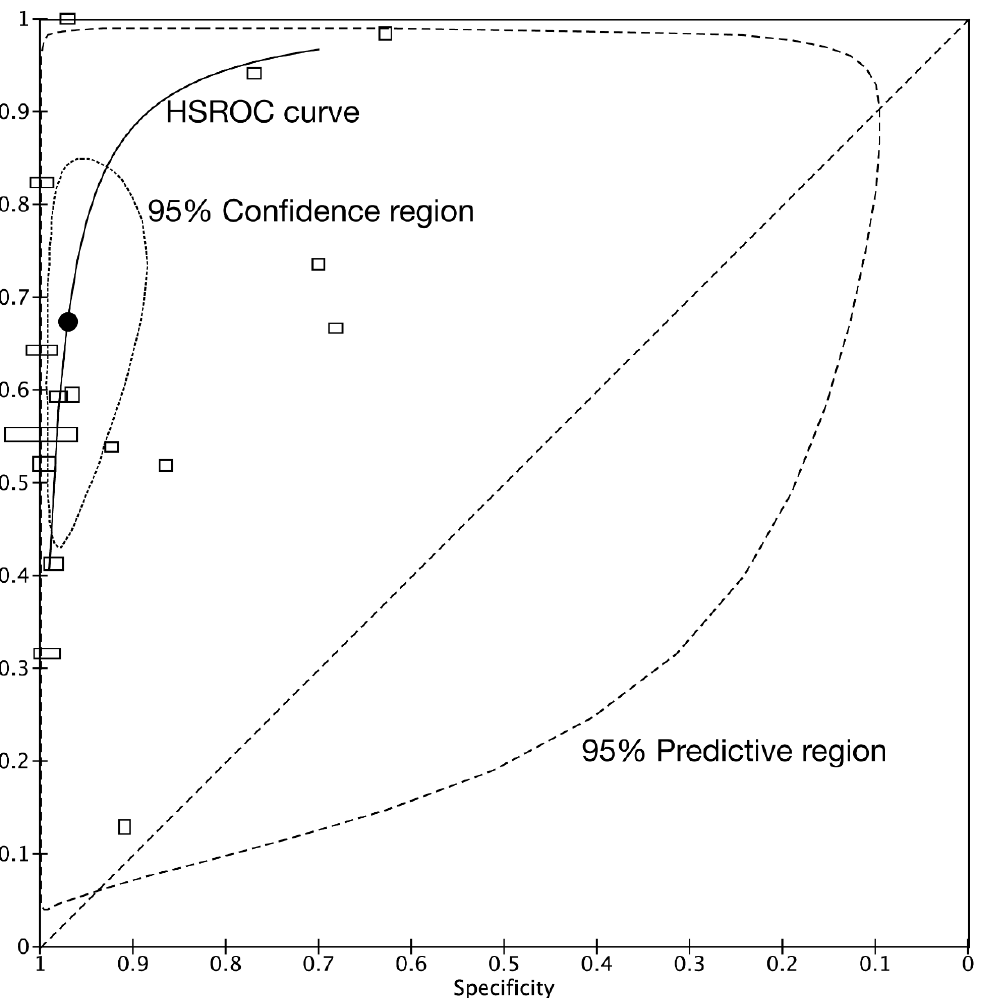
Figure 5. Summary receiver operating characteristic curves from all included studies. The dotted line represents the theoretical plot of a test with no discrimination ability. The summary ROC curve can be drawn through these values. The summary point estimate (black point) and its 95% confidence region are shown. The height of the rectangles is proportional to the number of patients with traumatic hollow viscus injuries across studies, and the width of the rectangles corresponds to the number of patients without traumatic hollow viscus injuries.